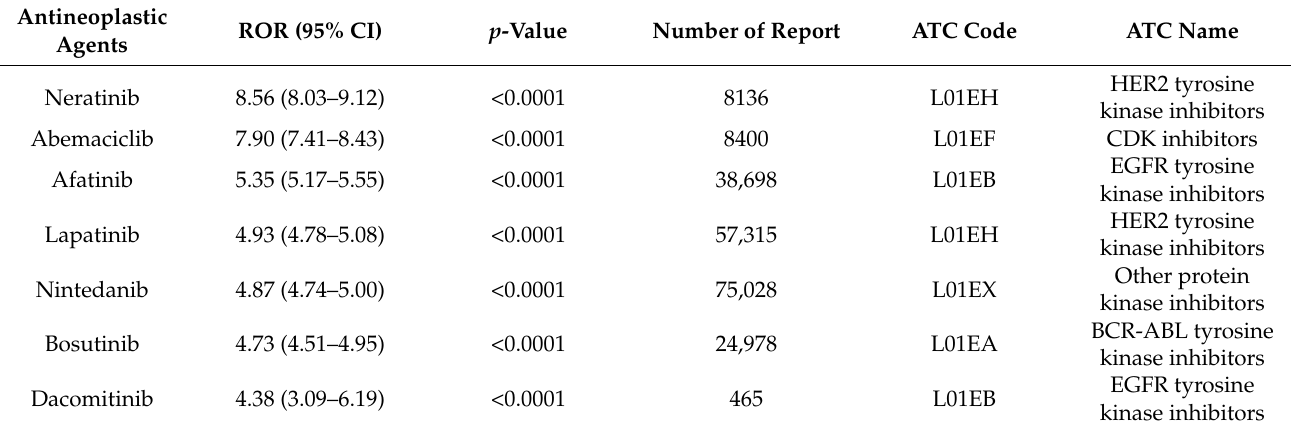
Table 1. The drugs with highest RORs of